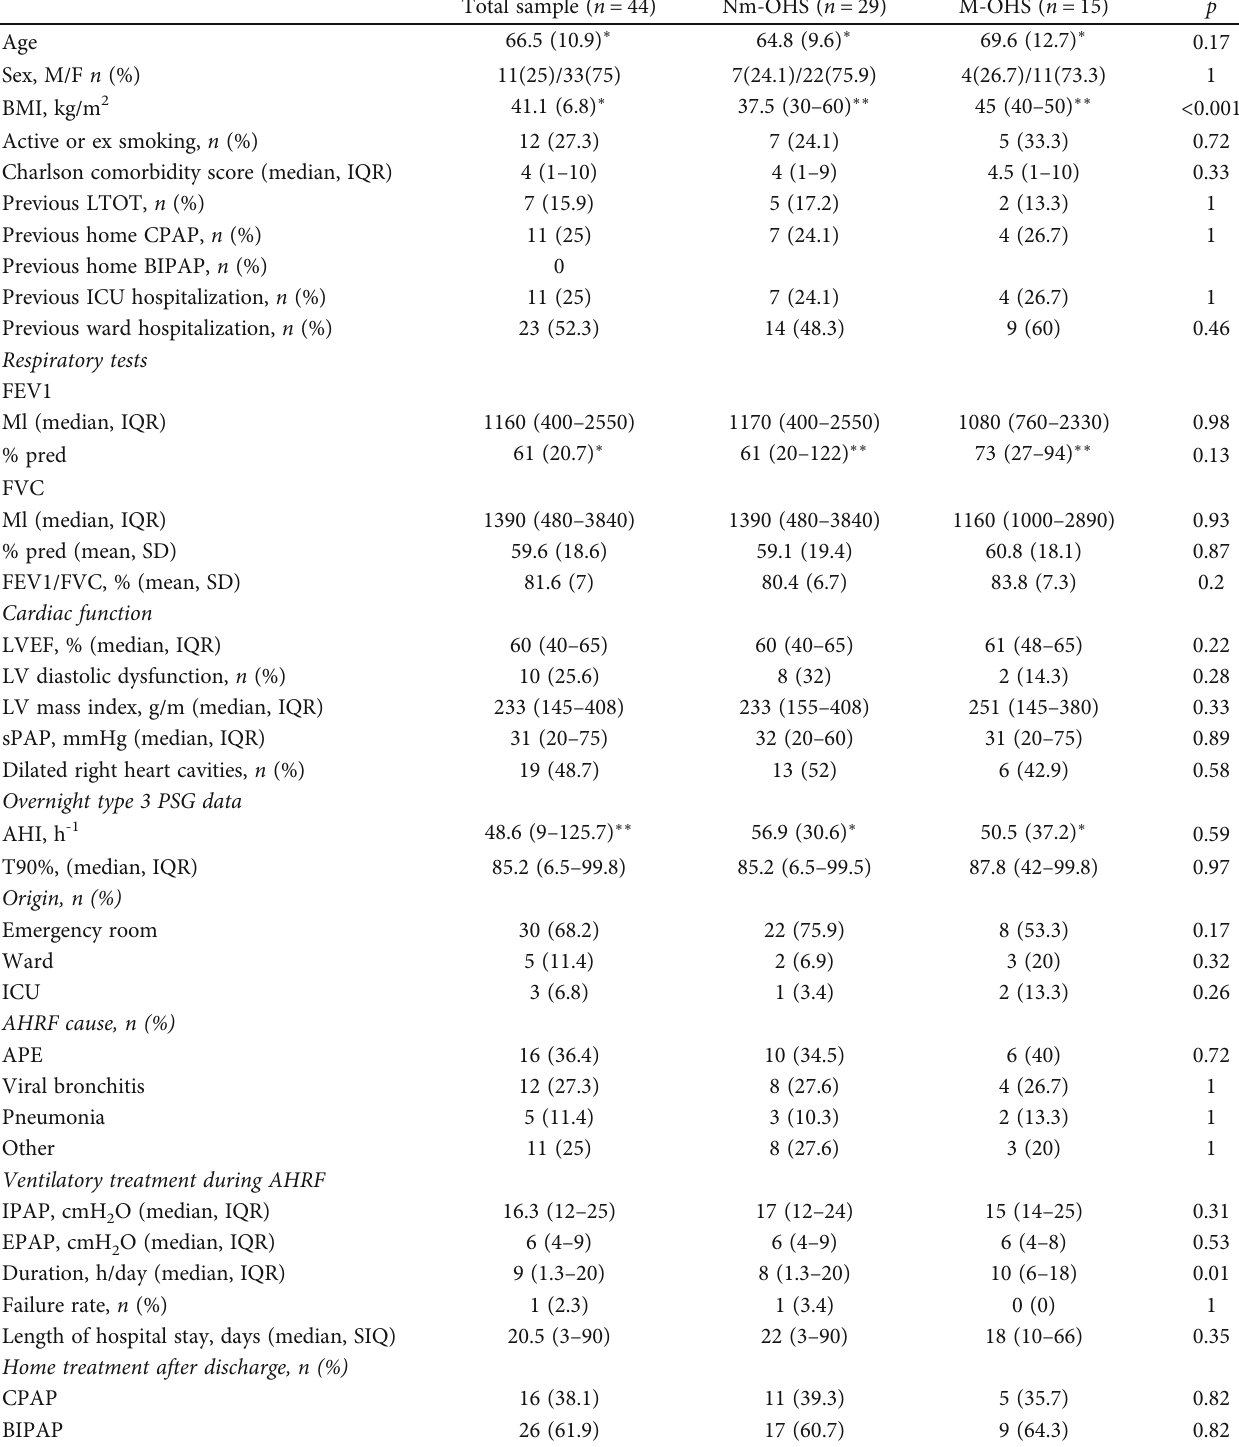
Table 1: Clinical, functional, and therapeutic characteristics of